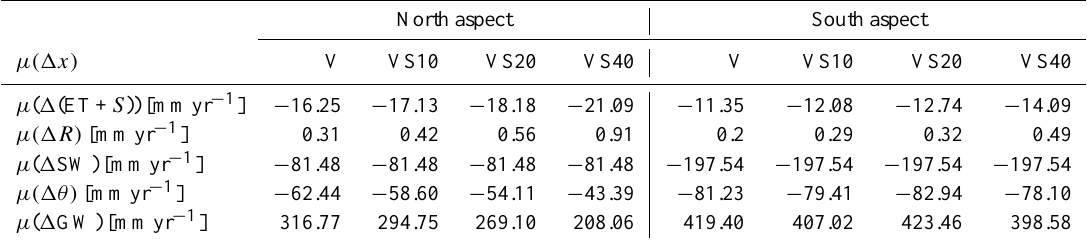
Table 4. Mean annual differences between forest thinning scenarios (V, VS10, VS20, VS40) and reference case for atmospheric losses (ET+ S ), runoff ( R ), snow water equivalent (SW), vadose zone moisture ( θ ) and groundwater storage (GW) across eight element pairs with contrasting (north, south) hillslope